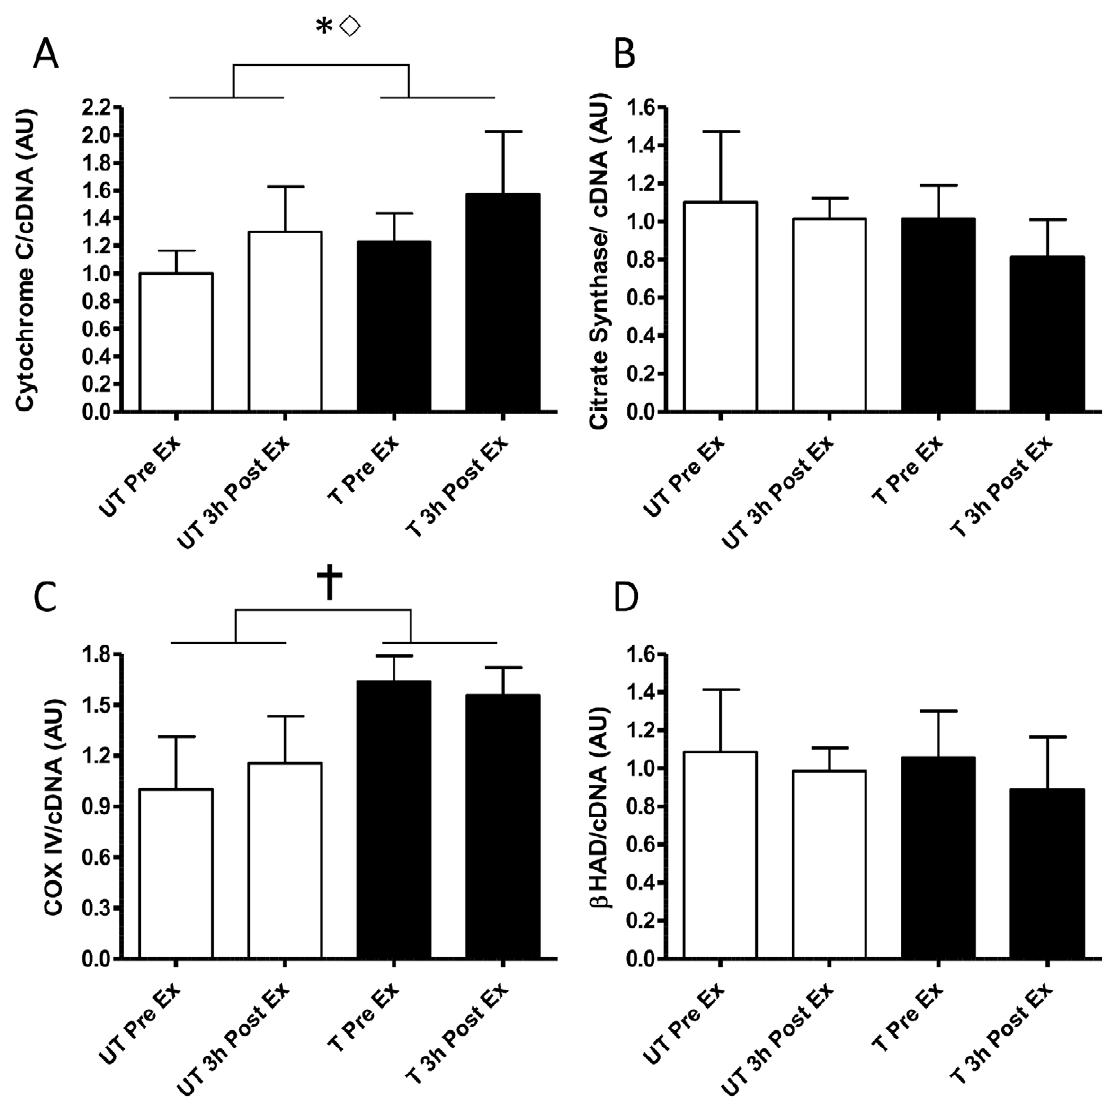
Figure 3. Changes in normalised gene expression of representative mitochondrial proteins in response to the same 1 h cycling bout ( , 164W or , 72% VO 2peak ) before and after 10-d of intensified cycle training. A-,electron transport system protein cytochrome c, B- b -Hydroxyacyl CoA Dehydrogenase ( b -HAD), C-cytochrome c oxidase subunit IV (COXIV) and D- citrate synthase. Data are mean 6 SD for n=9. pre- training exercise bout (open bars); post-training exercise bout (closed bars); Pre Ex-resting sample just prior to exercise. 3 h Post Ex -sample take 3 h after exercise; - main effect of training P , 0.001; * - main effect of training P , 0.05; e -main effect of time P , 0.05.